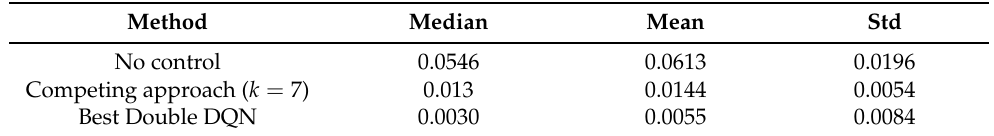
Table 2. Performance comparison in terms of MSE statistical properties for the proposed solution and the competing approach (proportional control) for 20 TCLs feeder.